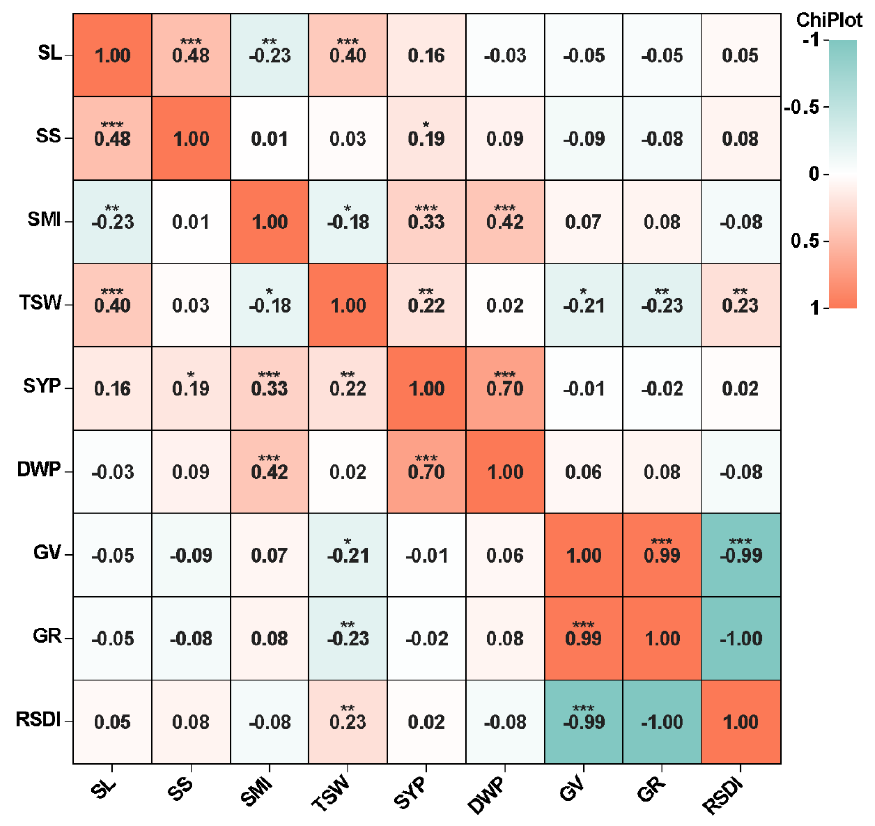
(Figure S2A; Table S1). SLAF tags on chromosome A10 had the highest polymorphic rate (57.52%), while the SLAF tags on chromosome C09 had the lowest polymorphic rate (33.78%). Furthermore, a total of 1,620,818 SNPs were developed from 304,506 polymorphic SLAF tags (Figure S2B), and 10,658 SNPs were selected as the candidate SNPs for GWAS analysis using the criteria of integrity ratio of >0.8 and MAF of >0.05. LD was estimated as the R 2 value. It was found that R 2 ranged from 0.26 on chromosome A05 to 0.37 on chromosome C01, with an average of 0.3, revealing the differences in the level of LD among chromosomes (Table S2). The average LD decay distance was about 300.33 kb at a threshold of R 2 = 0.1 (Figure 2).